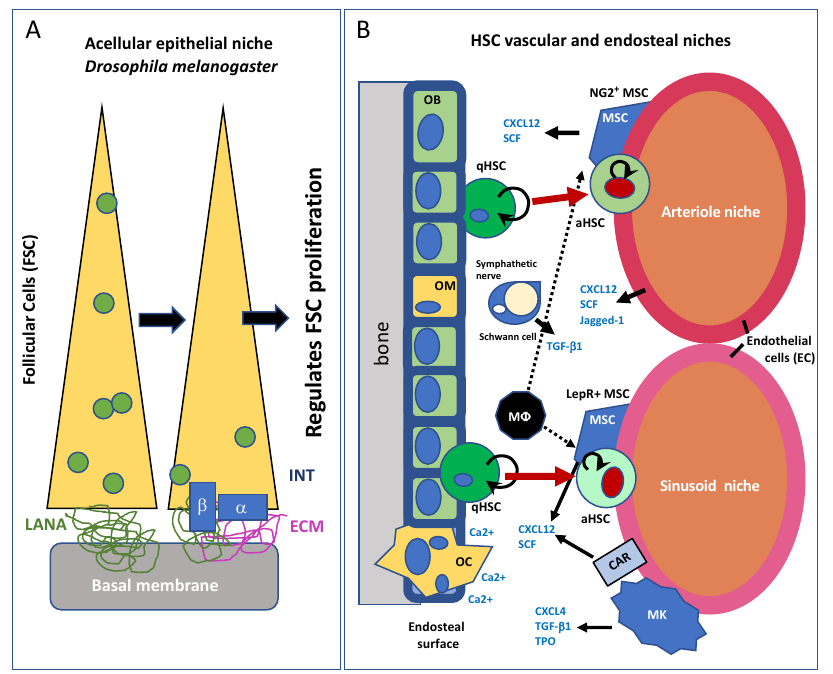
Figure 1. Examples of stem cell niches. (A) : The acellular epithelial niche in Drosophila melanogaster. The ovary follicular cell compartment (FSC) is indicated with a yellow triangle; INT, integrins; a/b subunits; ECM, extracellular matrix; LANA, laminin A. Adapted from [O’Reilly et al., 2008]. The model is not conserved in mammal. (B) : Simplified scheme for the bone marrow hematopoietic stem cell (HSC), composed of two subniches, the endosteal and the vascular niches. qHSC, quiescent hematopoietic stem cells; aHSC, activated hematopoietic stem cells; MSC, mesenchymal stem cells; MF, macrophages; MK, megakaryocytes; OB, osteoblasts; OC, osteoclasts; OM, osteomacs CAR, CXCL12-abundant reticular cells.